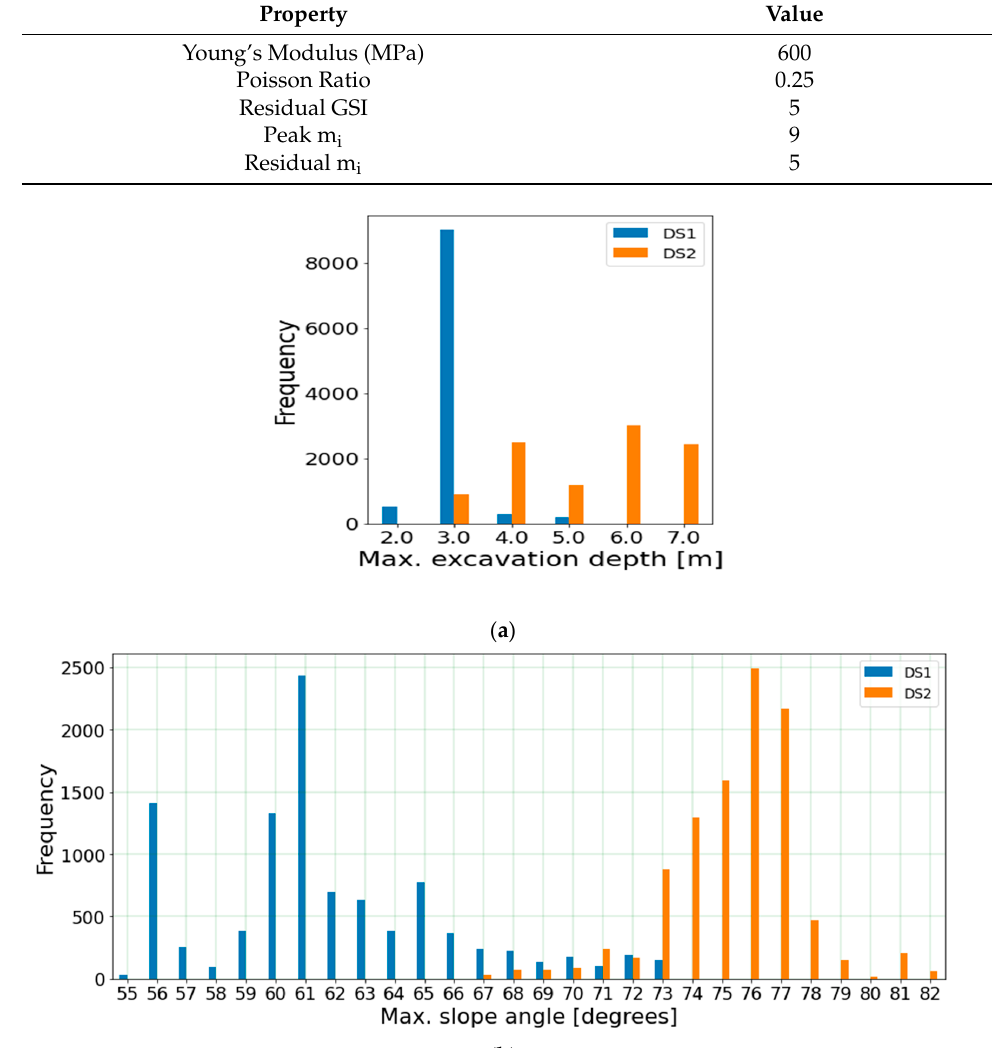
Figure 14. Histograms for ( a ) maximum excavation depth and ( b ) maximum slope angle according to the data sets DS1 and DS2. to the data sets DS1 and